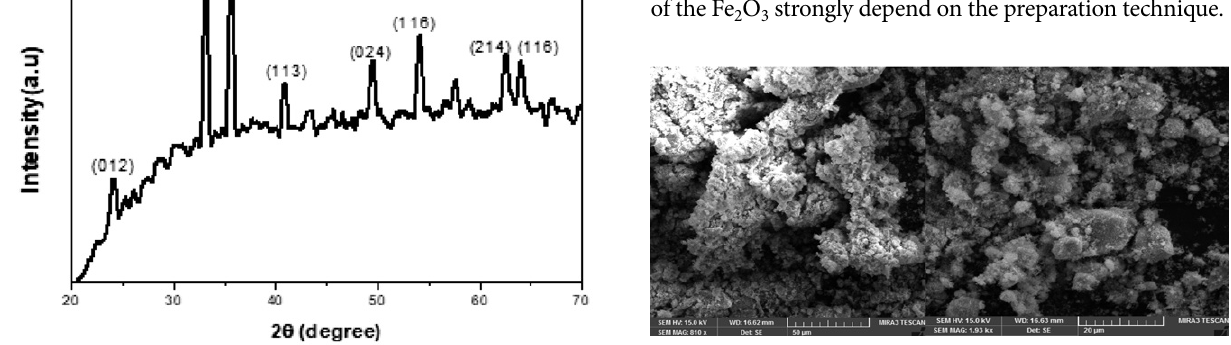
Figure 1. XRD patterns of the Fe 2 O 3 NPs.